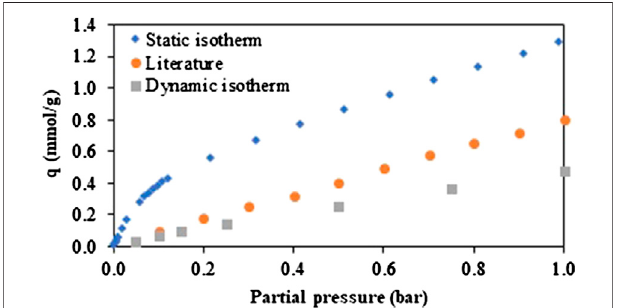
FIGURE5| Normalizedbreakthroughcurvesatdifferentadsorption fl ow rates. 0.5 Nl/min (blue), 1 Nl/min (orange), 2 Nl/min (gray) and 5 Nl/min (yellow). Adsorption was performed at room temperature (25 ° C) and using a feed gas containing 15 v% CO 2 .